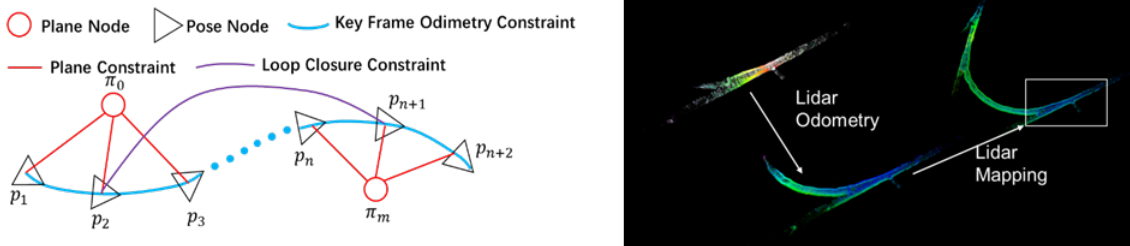
Figure 2. Graph optimization and point cloud map construction diagram. {𝑝 1 , 𝑝 2 ,. . . 𝑝 𝑛+2 } is the key frame pose node, and {𝜋 0 ,𝜋 1 ,. . . 𝜋 𝑛 } is the extracted roadway ground plane coefficient node.